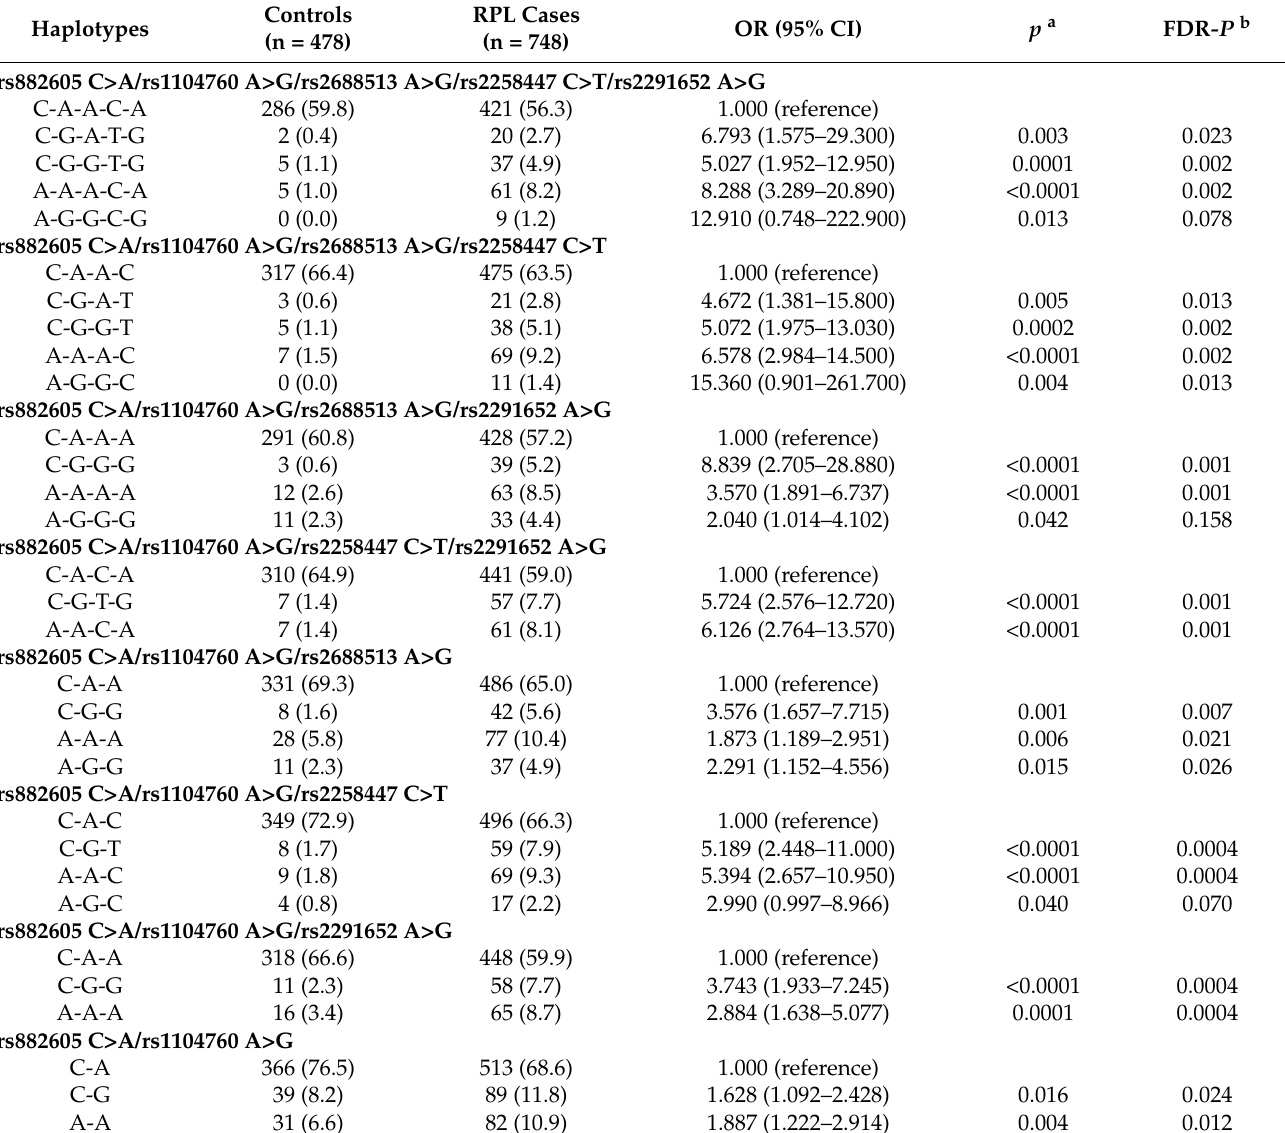
Table 3. The haplotype analysis of the MUC4 polymorphisms with an increased odds ratio in the RPL patients and control